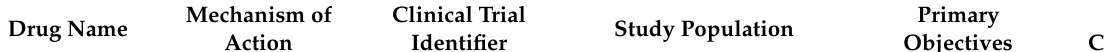
Table 1. Ongoing phase 3 clinical trials of PCSK9